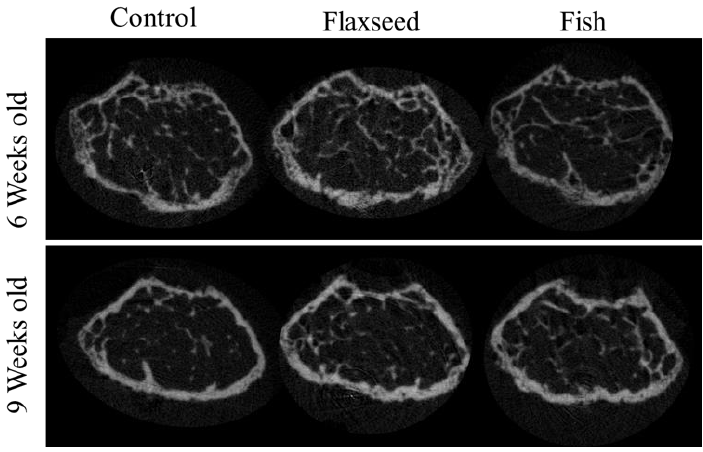
Figure 5. 3D images of trabecular bone from 6- and 9-week-old mice.